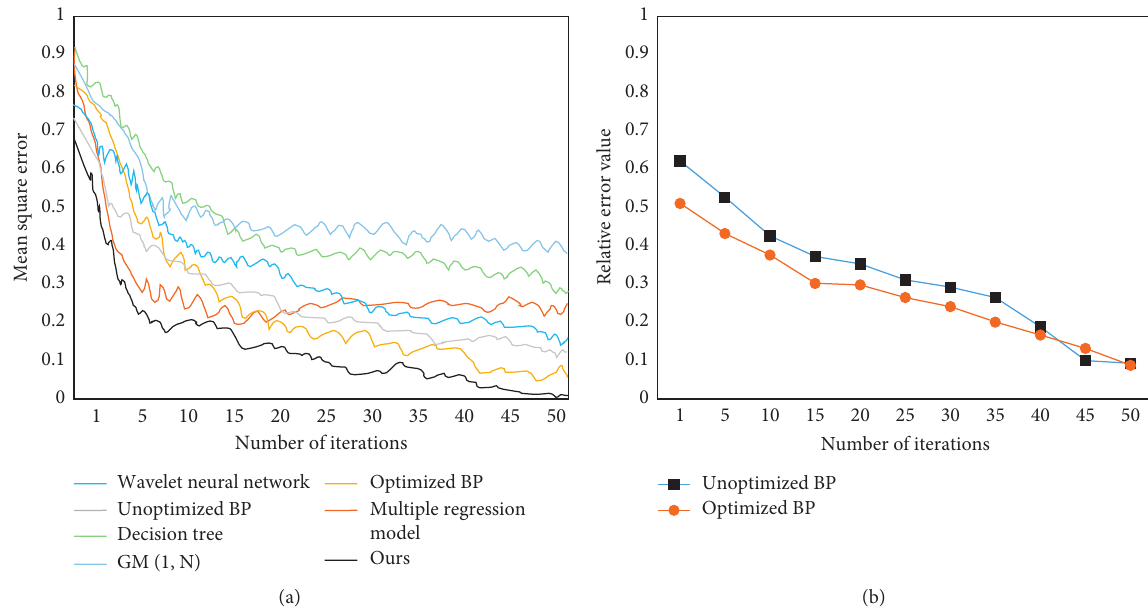
Figure 7: Convergence curves and prediction errors of different prediction models. (a) Convergence curves of different prediction al- gorithms. (b) Prediction error before and after BP network optimization.